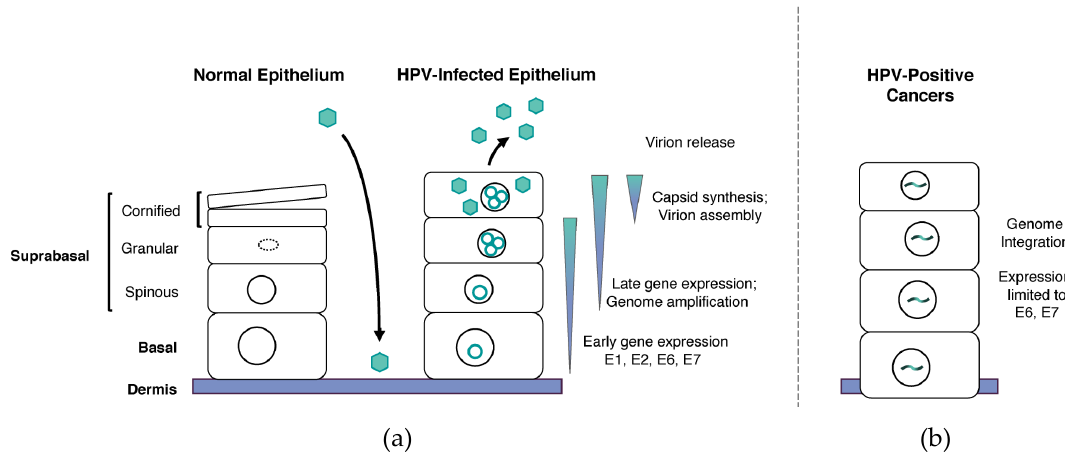
Figure 1. Human papillomavirus (HPV) life cycle. ( a ) Epithelial differentiation program in normal and HPV infected keratinocytes. In normal epithelium, cellular replication occurs in the basal layer of cells. When these cells divide, one daughter cell migrates upwards into differentiated suprabasal